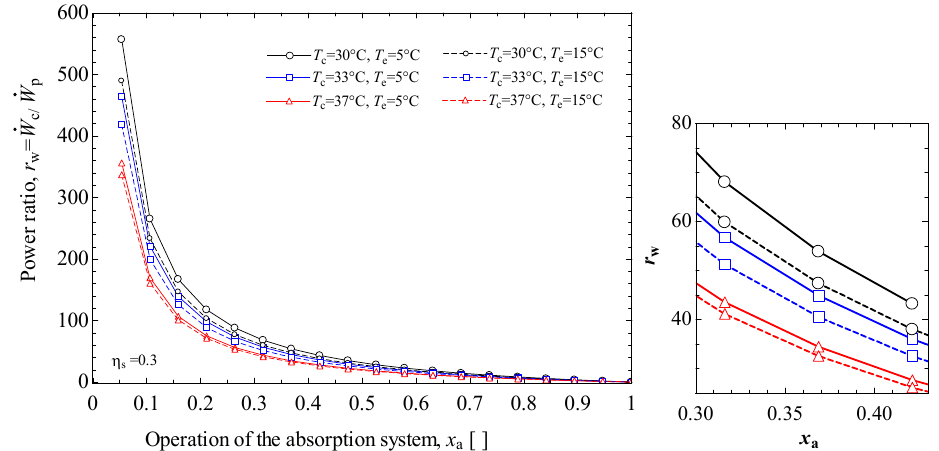
Figure 3. Cooling and supply heat in the hybrid chiller relative to the operating ratio of the cooling systems, x a .